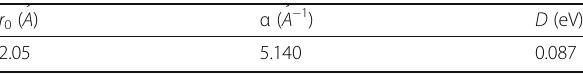
Table 2 Parameters value in Morse